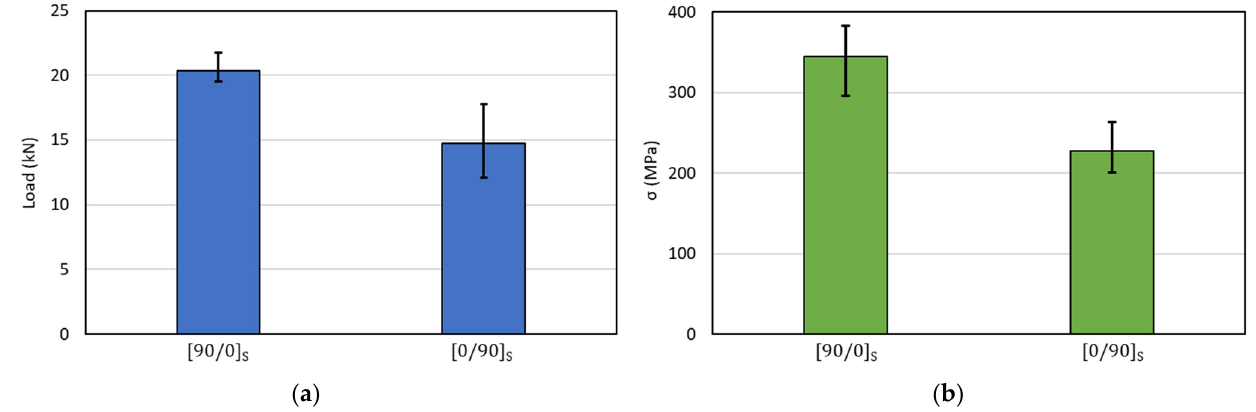
Figure 11. ( a ) The average of maximum load of the specimen and ( b ) strength (maximum stress) of the specimen.